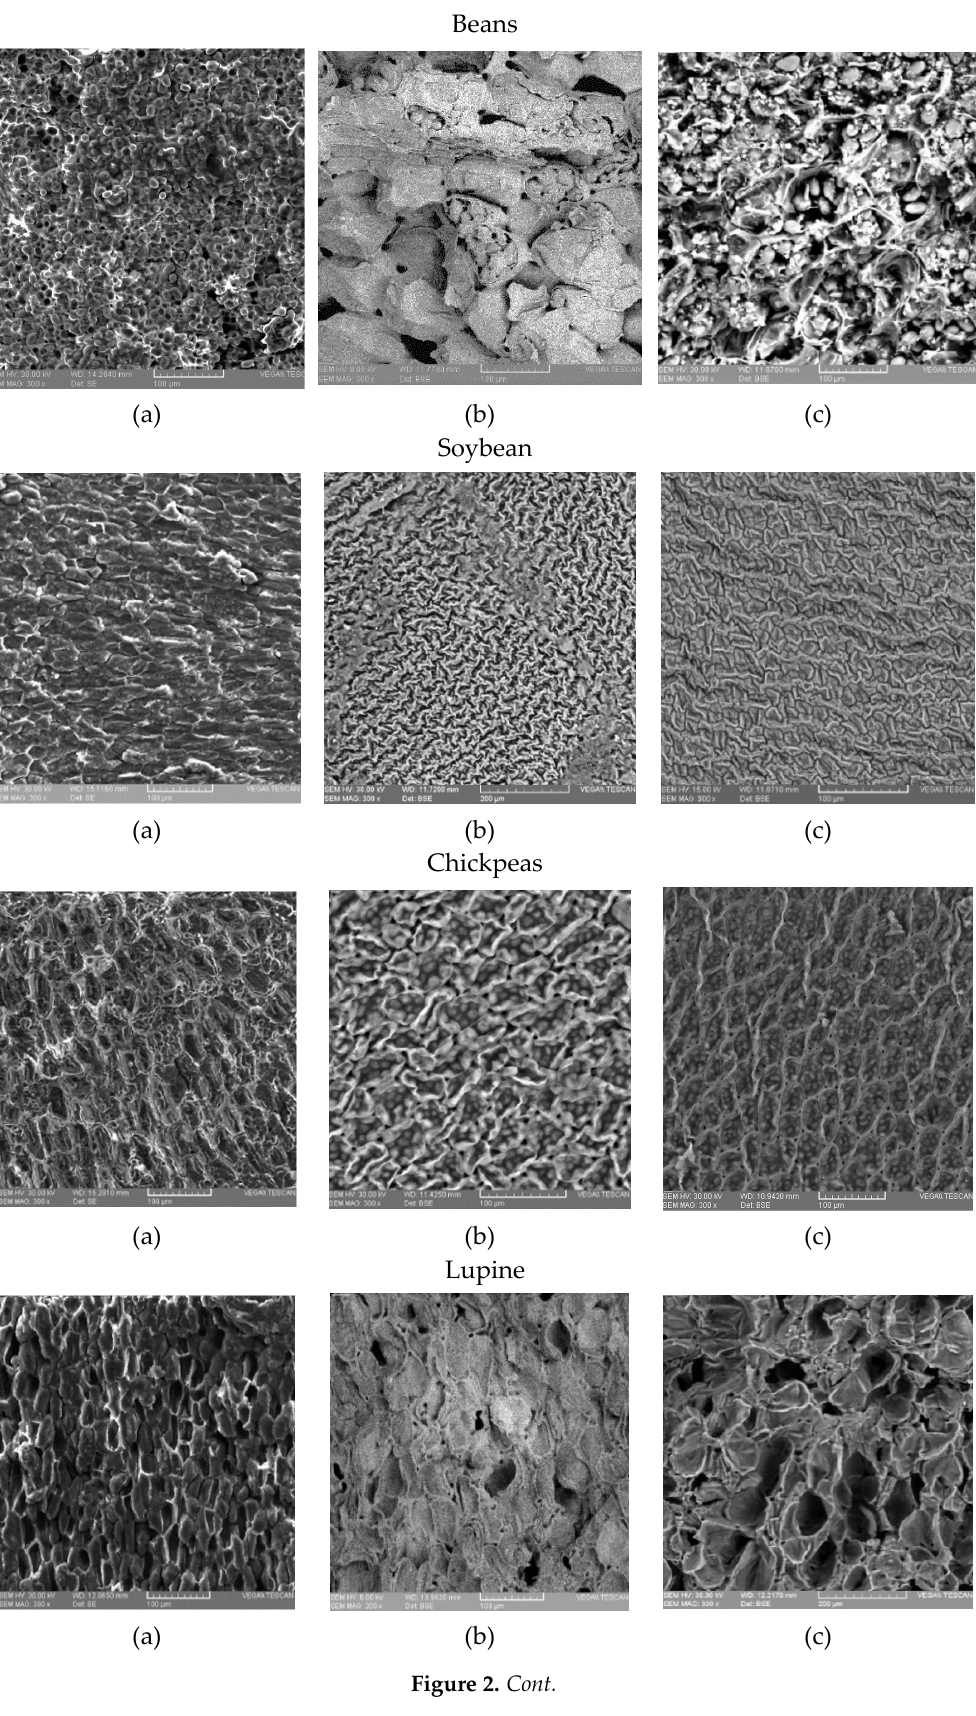
Lentil Figure 2.